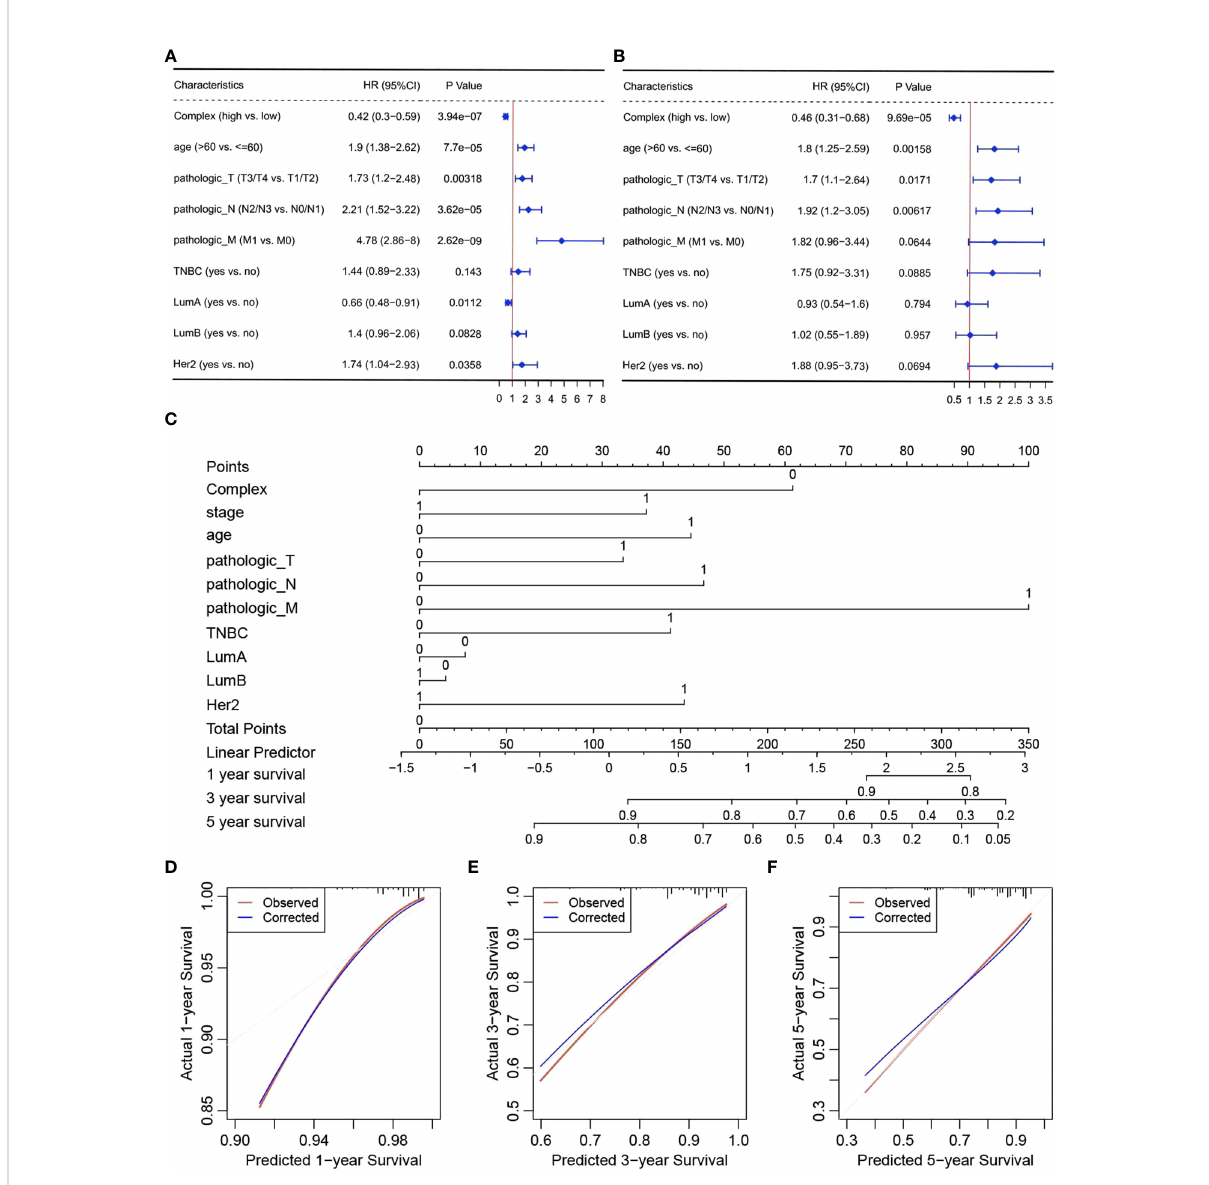
FIGURE 4 Independent prognostic ef fi cacy of complex prognostic values. Results of (A) univariate and (B) multivariate Cox regression analyses, (C) nomograms, and calibration curves for survival at (D) one (E) 3 and (F) 5